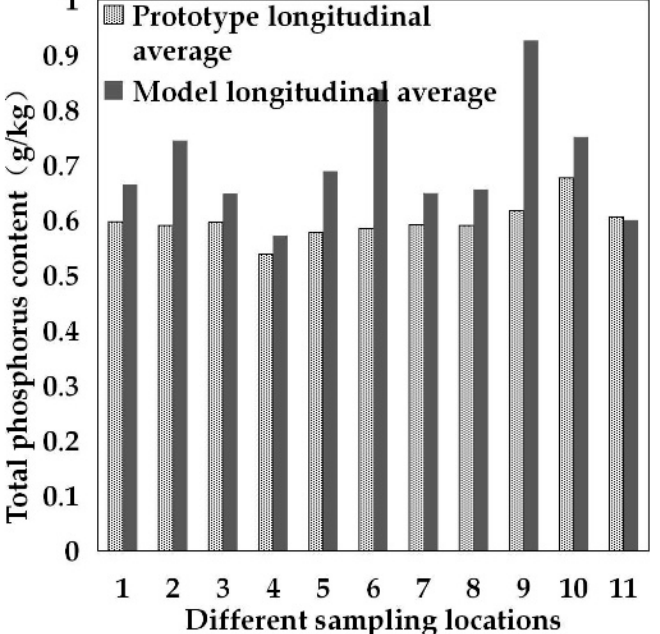
Figure 10. Total phosphorus content at each sampling point for the prototype and model of the small watershed.